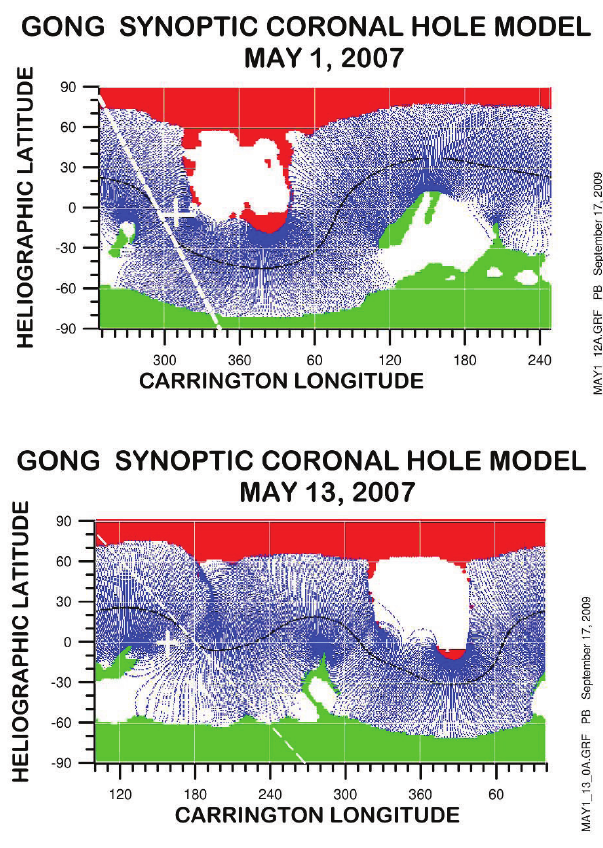
Fig. 4. Calculated coronal hole configurations according to GONG: Assuming a constant wind speed, we find the magnetic configu- ration at the source surface at the time, when a solar wind parcel left the Sun. Green denotes open field lines with positive polar- ity, red indicates negative polarity. The blue lines connect bound- aries between open and closed magnetic field. The intercept of the black neutral line with the solar equator near the sub-terrestrial point (white cross) is taken for the location of the interface at the source. The parameter d , i.e., the slope of the interface at the source, has been derived from the white dashed line.